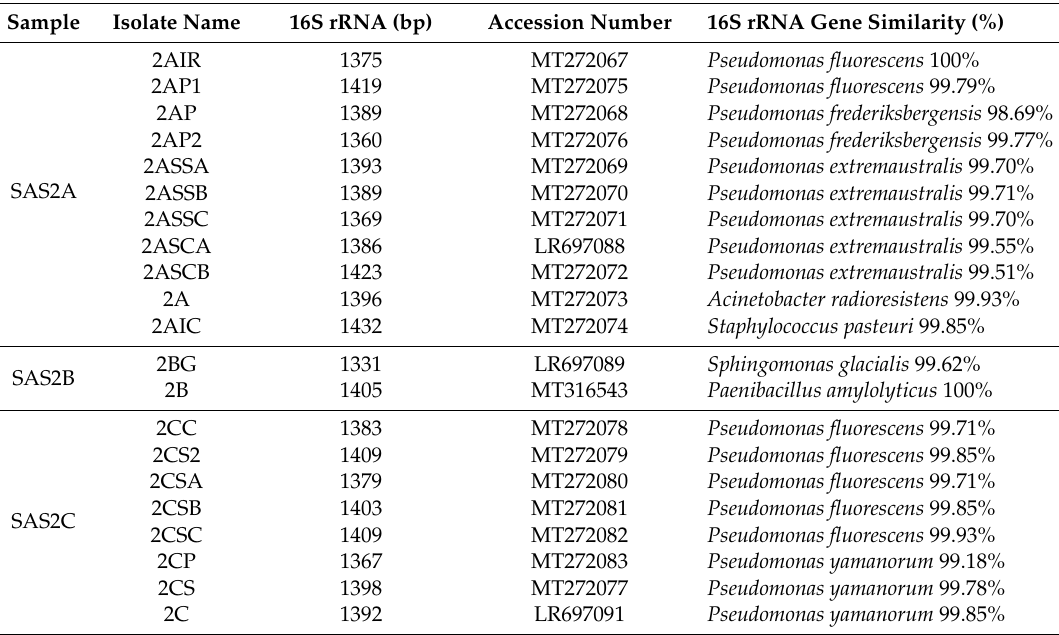
Table 2. Identification of isolates by 16S rRNA gene